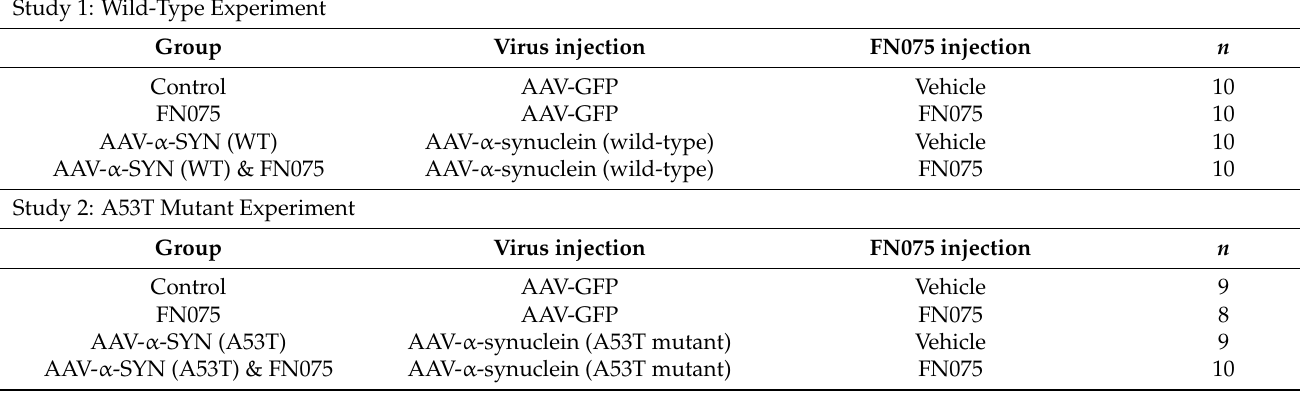
Table 1. Groups used in these two studies. In the first experiment, the AAV vector expressed the wild-type human α -synuclein transgene, while in the second experiment, the AAV vector expressed the A53T mutant human α -synuclein transgene. AAV vectors were injected unilaterally into the substantia nigra followed four weeks later by administration of FN075 at the same site. See text for more methodological